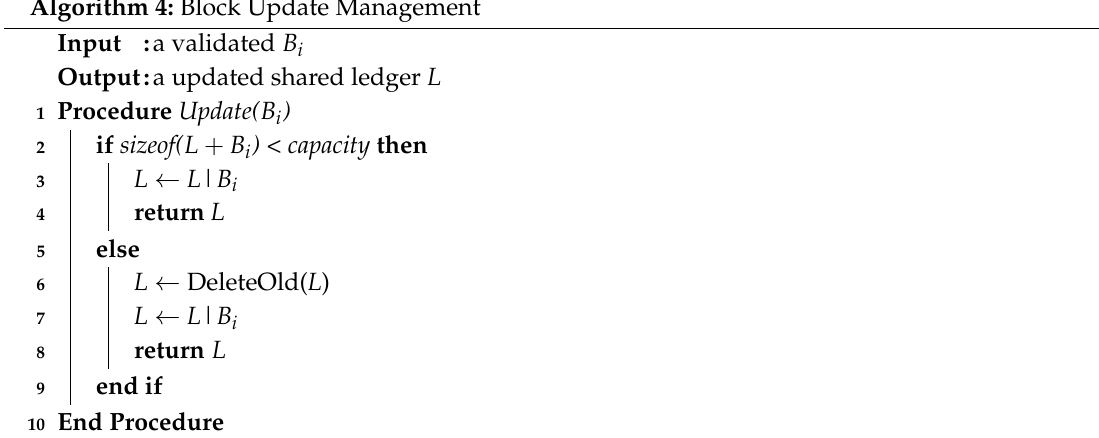
Algorithm 4: Block Update